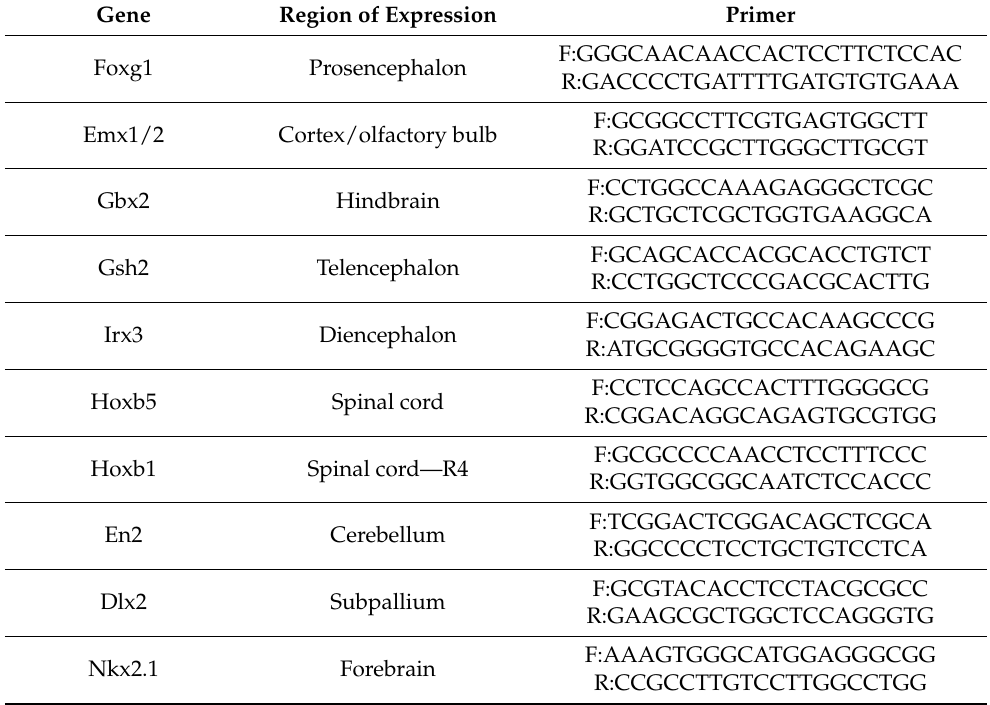
Table 1. Positional identity: gene and primers used to identify the brain region of the tissue samples.